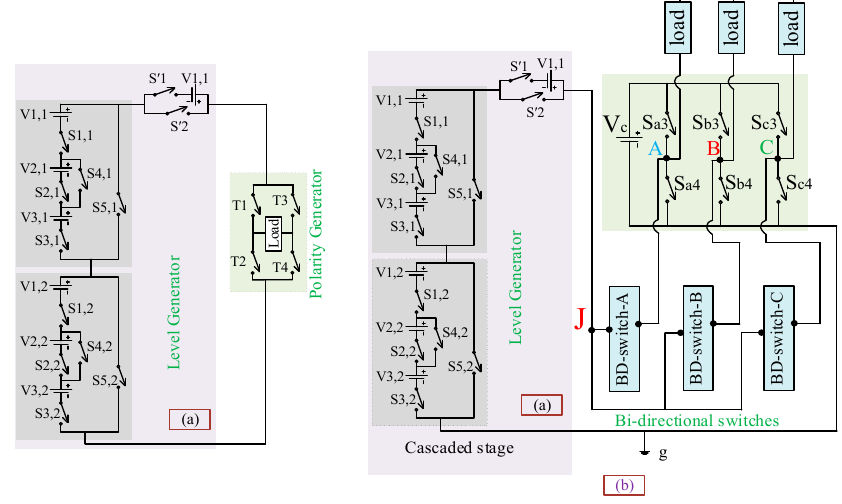
Figure 11. Three-phase conversion of a single phase topology ( a ) existing single phase topology proposed in [12]; ( b ) three-phase conversion of existing topology according to the concept proposed in this paper.